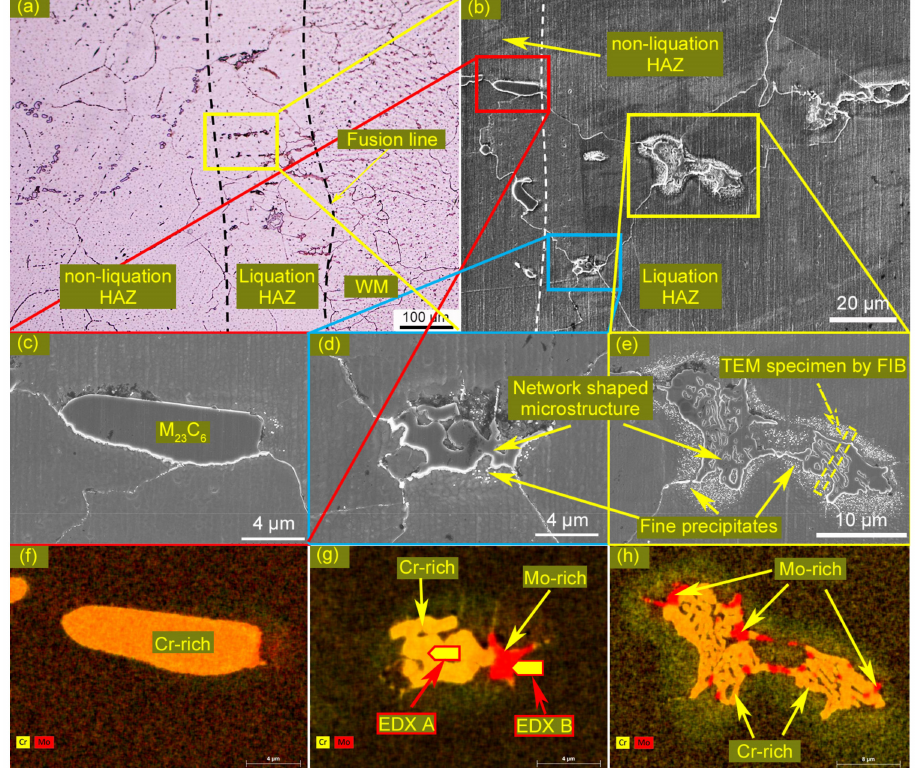
Figure 4. Microstructure of the welded joint including HAZ and WM. ( a ) OM; ( b ) is a magnified image of HAZ in ( a ) obtained by SEM; ( c – e ) are magnified zones marked by red / blue / yellow rectangles in ( b ) obtained by SEM, respectively; ( f – h ) are chemical compositional mappings of microstructures in ( c – e ),